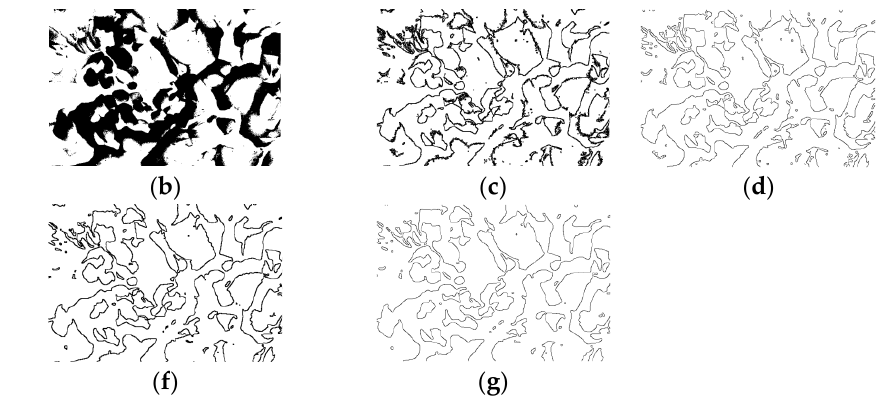
Figure 5. ( a ) SEM image of A1La5 processed at 1500 °C at scale: 50 μ m; ( b ) image converted to bi- nary; ( c ) detected edges (Find Edges tool) giving an FD = 1.887; ( d ) detected edges (Canny Edge Detection plugin) giving an FD = 1.717; ( e ) image converted to binary with the median filter ap- plied, ( f ) detected edges median filter applied, FE tool, FD = 1.751; ( g ) detected edges, median filter applied, CED plugin, FD = 1.605.